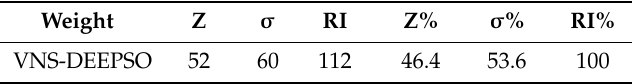
Table 4. Strategies according to the objective function.